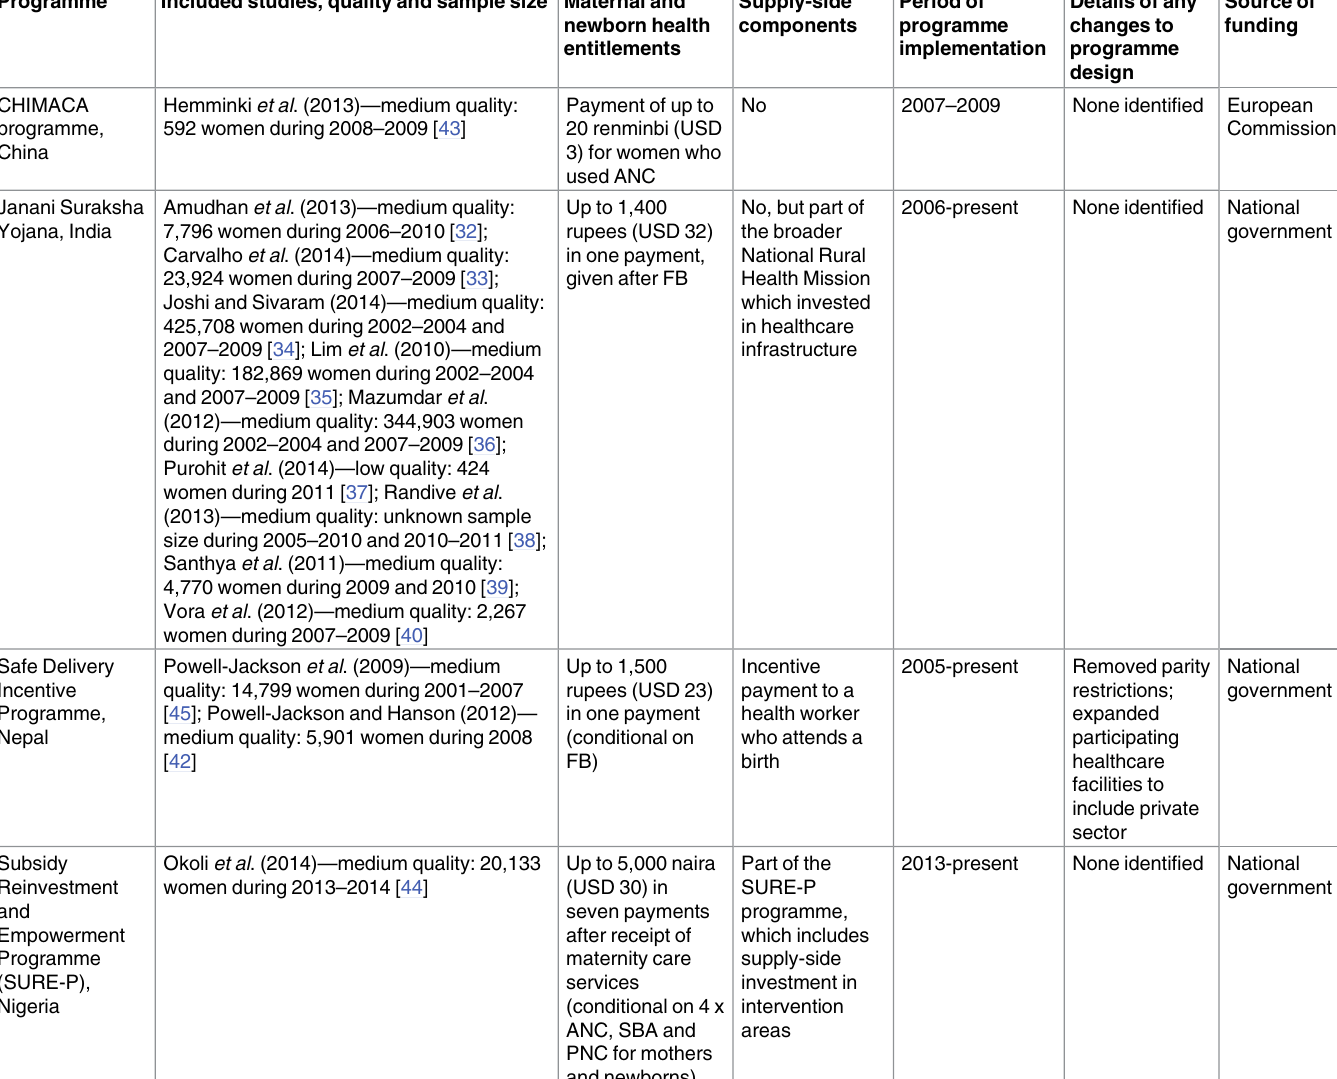
Table 5. Details of short-term cash payment programmes included in the systematicreview. Programme Included studies, quality and sample size Maternal and